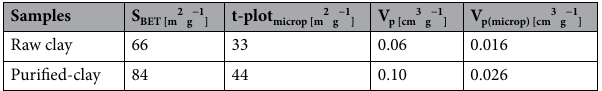
Table 3. Textural parameters of raw clay and purified clay.